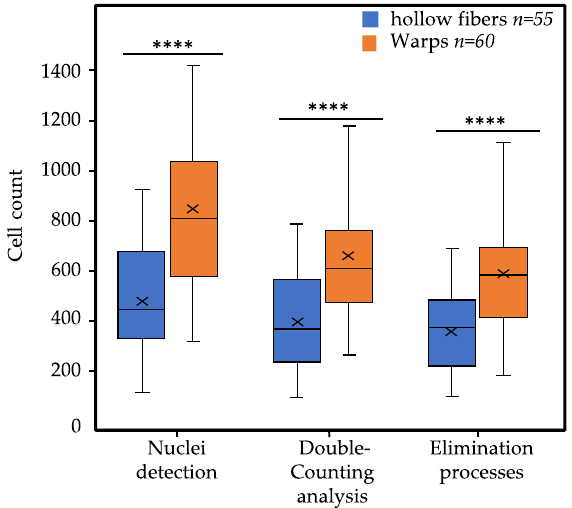
Figure 11. Boxplots showing the distribution of the total number of cells per predilection site after each post-processing step in Deetect. Middle line = median; X = mean; box = interquartile range (IQR); upper/lower whisker (UW/LW) ≈ 1.5xIQR. The result of the Mann–Whitney U test is shown using the following annotation: ****, p ≤